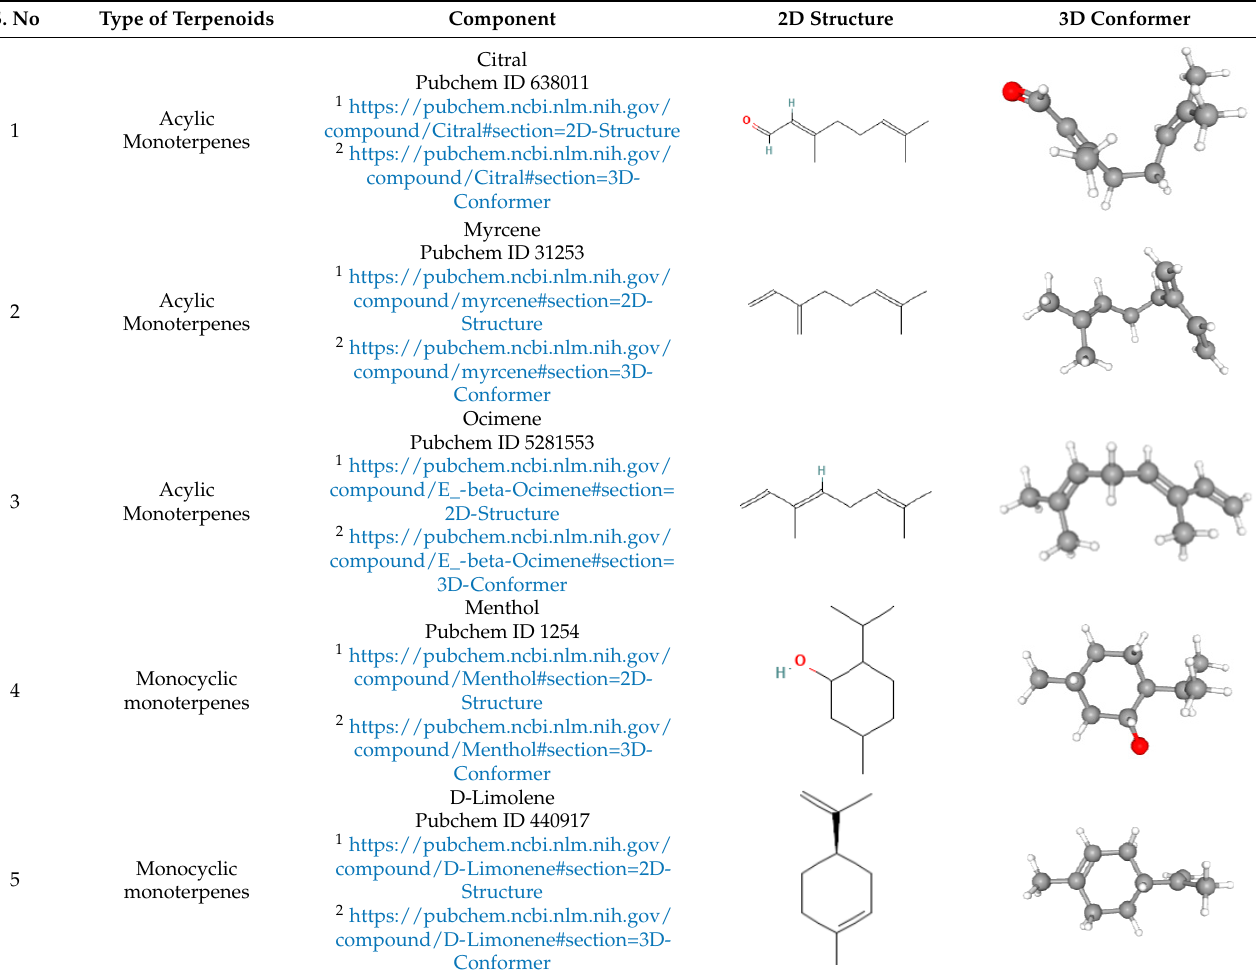
Table 1. Structure of the representative volatile aromatic terpenes. Structures have been adapted